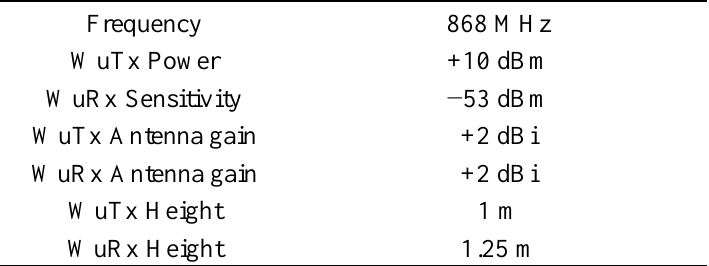
Table 1. Parameters for simulation of operational distances of the SCM-WuR system.